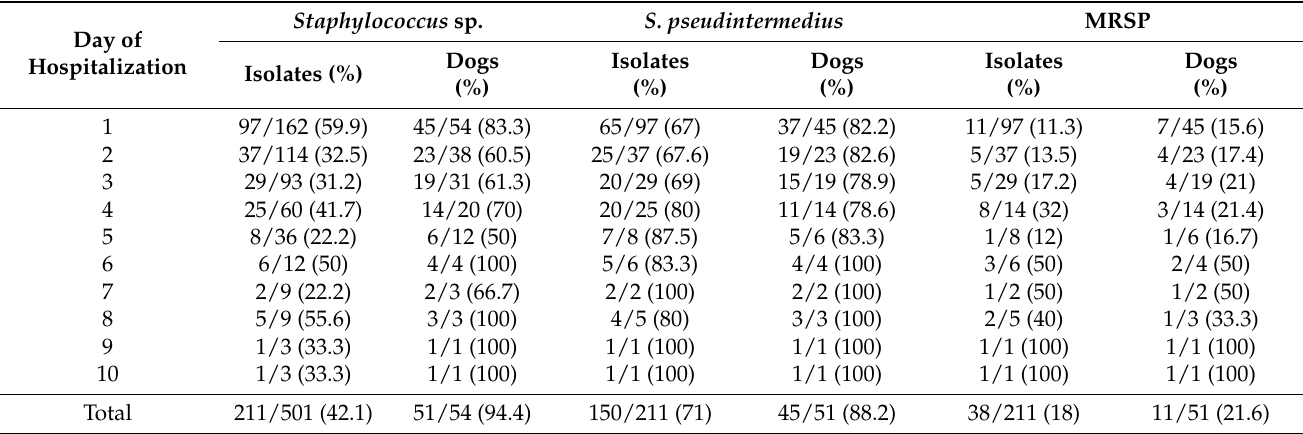
Table 2. Frequency of total and per day hospitalization isolates of Staphylococcus spp., S. pseudinter- medius and MRSP recovered from 54 dogs admitted to the ICU of HV-UFMG between August 2018 and April